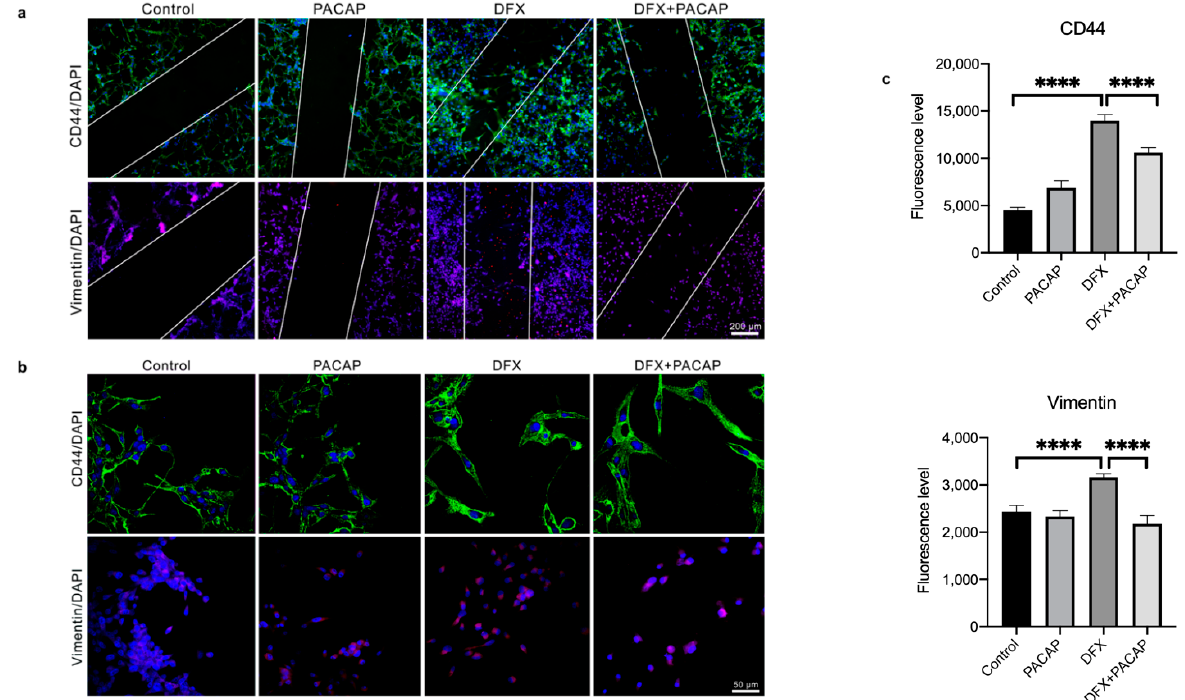
Figure 8. PACAP effect on CD44 and Vimentin expression in migrating GBM cells exposed to hypoxia mimetic conditions. Immunosignal of CD44 and Vimentin protein in U87MG cells cultured with PACAP or DFX or DFX plus PACAP or vehicle for 24 h. ( a , b ) The CD44 and Vimentin signals were detected using specific primary antibodies revealed with the Alexa Fluor 488 secondary antibodies (green fluorescence) and Alexa Fluor 594 secondary antibodies (red fluorescence), respec- tively. Cell nuclei were stained with diamidino-2-phenylindole, DAPI (blue fluorescence). The photomicrographs in panel b represent randomly acquired images from regions surrounding the wound area. Panels a and b show representative results taken from different fields in randomly selected slides and scanned by confocal laser scanning microscopy (CLSM). Scale bars (200 and 50 μ m). ( c ) Fluorescence intensities graphs were obtained with the “Profile view” function of ZEN- 2011 software; the fluorescence red, green and blue were read for each pixel along the lines, and the graphs reflect, in arbitrary units, the proportion of the pixel intensity in the three wavelengths. Data represent means ± SEM (**** p < 0.0001). 4. Discussion GBM, the most common and fatal type of brain tumor, is characterized by high de- gree of cellular heterogeneity and the strong ability to invade the surrounding tissue. GBM contains areas of intra-tumor necrosis that are typically associated to extensive hy- poxic foci. The hypoxic event is principally mediated by HIFs, whose activation induces the transcription of a wide variety of genes involved in several pathways such as glycol- ysis, angiogenesis, invasion and EMT, all events playing a crucial role in GBM aggressive- ness [19]. Our previous study showed that PACAP counteracts the expression of HIFs via PI3K/AKT and MAPK/ERK pathways inhibition [17]. In the present work, we demon- strated that PACAP is mainly expressed in hypoxic areas as compared to weakly hypoxic regions of human GBM (Figure 1a,b). On contrary, PAC1R is diffusely localized in the tumor bulk (Figure 1c,d). In the cell, PACAP/PAC1R showed co-localization with HIF-1 α both in the cytoplasm and nucleus (Figure 2). In accord, Yu et al. [69] has previously de- scribed the translocation of PAC1R from cytoplasm into the nucleus based on PACAP concentration. At low concentration, the peptide induced the dimerization of PAC1R on perinuclear membrane, whereas at high concentration it promoted translocation of PAC1R dimers into the nucleus triggering different cell signaling. Furthermore, some in- sults caused up-regulation of PAC1R and its nuclear translocation to protect cells against oxidative stress damage [70]. The presence of PAC1R into the nucleus may be involved in a specific cell response to hypoxia. In accord, PACAP acts as negative regulator of HIF-1 α through the inhibition of PI3K/Akt and ERK1/2 signaling pathways, which interfere with